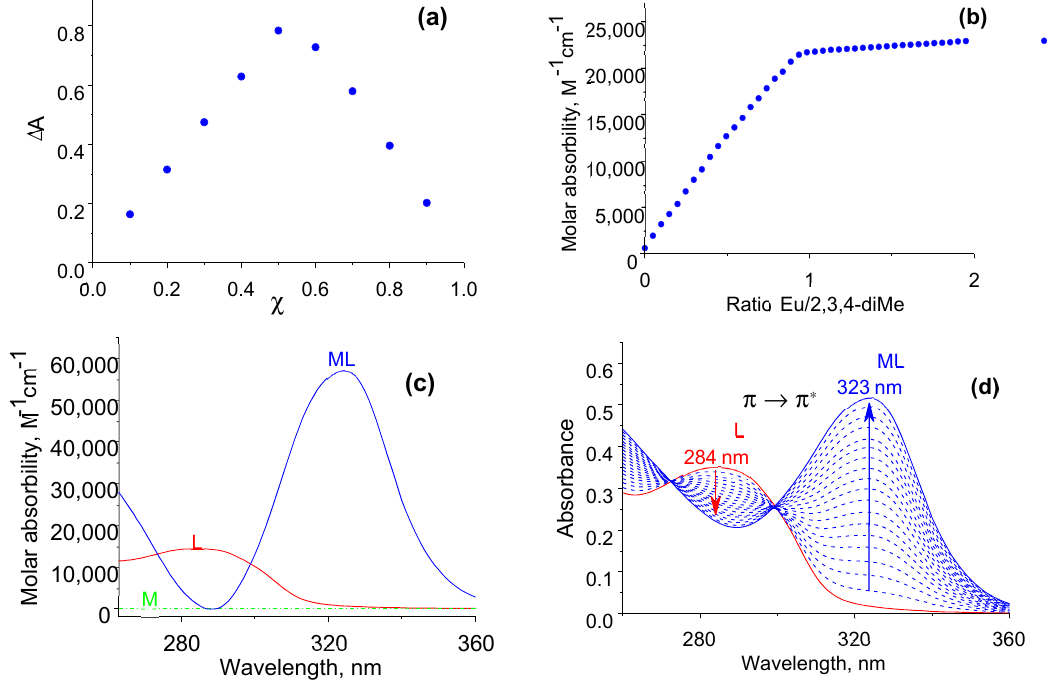
Figure 2. Spectrophotometric titration of 2·10 − 5 M 2,3,4-triMe anilide with a solution of 2·10 − 3 M Eu(NO 3 ) 3 •6H 2 O in acetonitrile (with water content ppm 400ppm): UV titration at 25 °C ( a ), titration curve at 323 nm ( b ), isomolar series for the europium complex with 2,3,4-triMe anilide ( c ), factorial analysis ( d ).